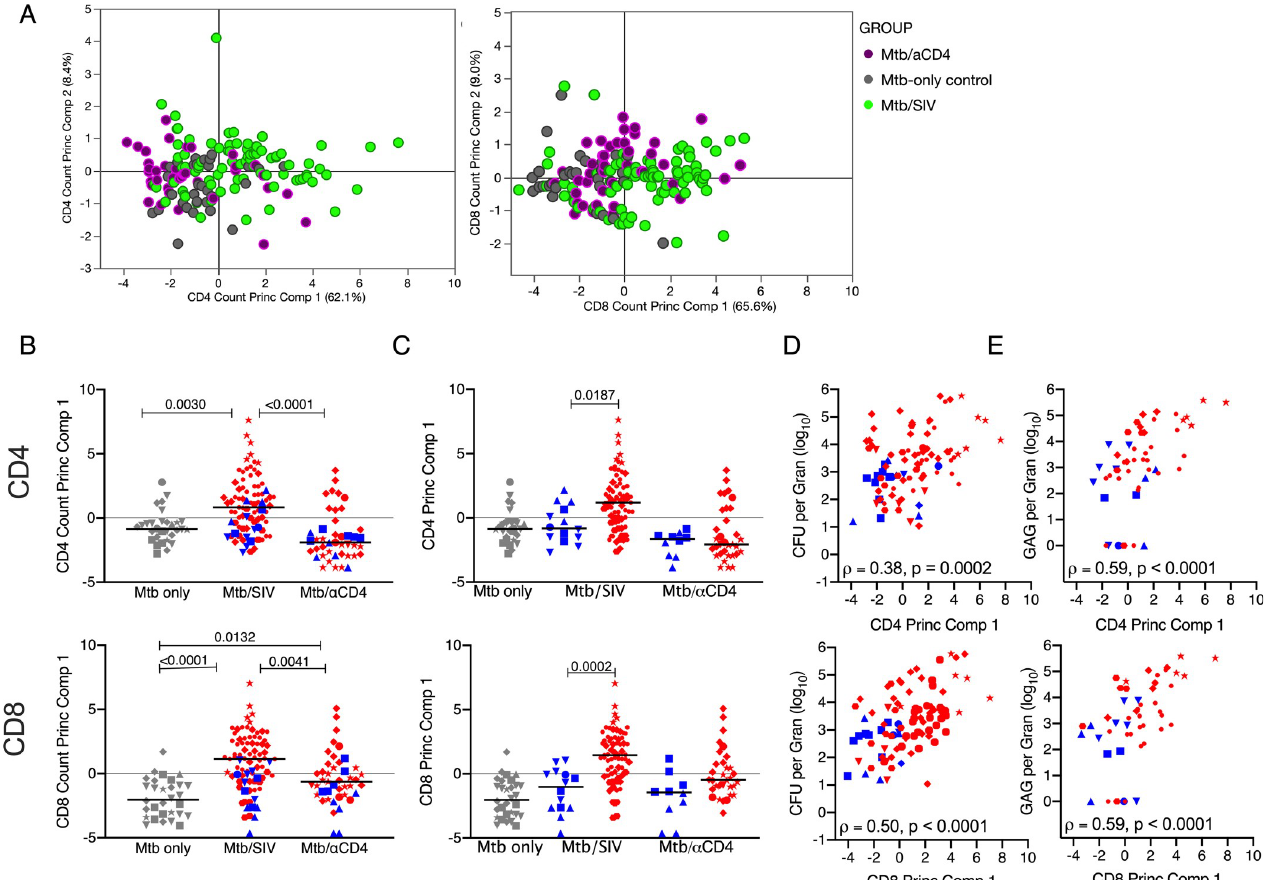
Fig 5. Principal component analysis demonstrates that SIV is associated with greater widespread T cells immune activation within the granuloma. A) Biplots are shown for the first two principal components. Each dot represents a granuloma. (Purple dots = granulomas from Mtb/ α CD4 NHP, green dots = Mtb/SIV NHP, and grey dots = granulomas from Mtb-only control NHP. B) Median scores of of principal component 1 (includes total numbers of CD4 and CD8 T cells producing IFN- α , IFN- γ , TNF, IL-2, IL-17, IL-10, IL-4 and Granzyme B are compared across treatment groups. Non-reactivators (blue) and reactivators (red) from Mtb/SIV co-infected and Mtb/ α CD4 NHP are shown. Individual monkeys are identified by different shapes. All treatment groups were compared using Kruskal-Wallis test with Dunn’s multiple comparison adjusted p-values reported. C) Median scores of principal component were compared between non-reactivators and reactivators within each treatment group. (Kruskal-Wallis Test with Dunn’s multiple comparison adjusted p-values reported.) D) The relationship between the CFU per granuloma (log 10 ) and the first principal component was tested using Spearman’s ρ for all treatment groups. E) In Mtb/ SIV NHP, the relationship between granuloma viral RNA quantification and the first principal component was tested using Spearman’s ρ . Each group contains the following number of granulomas: 30 Mtb-only Control, 43 Mtb/ α CD4, 83 Mtb/SIV.